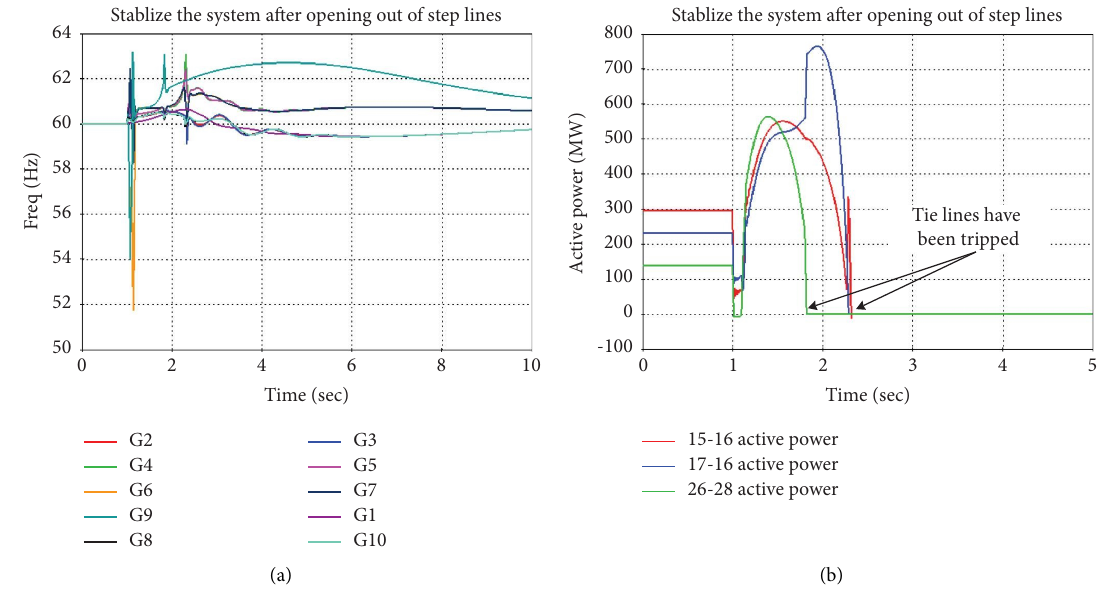
Figure 24: Stable islands after